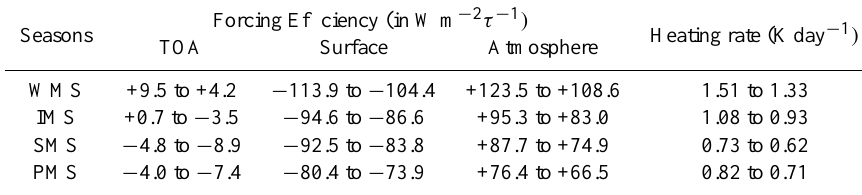
Table 5. The range of values for forcing efficiency obtained for different seasons.